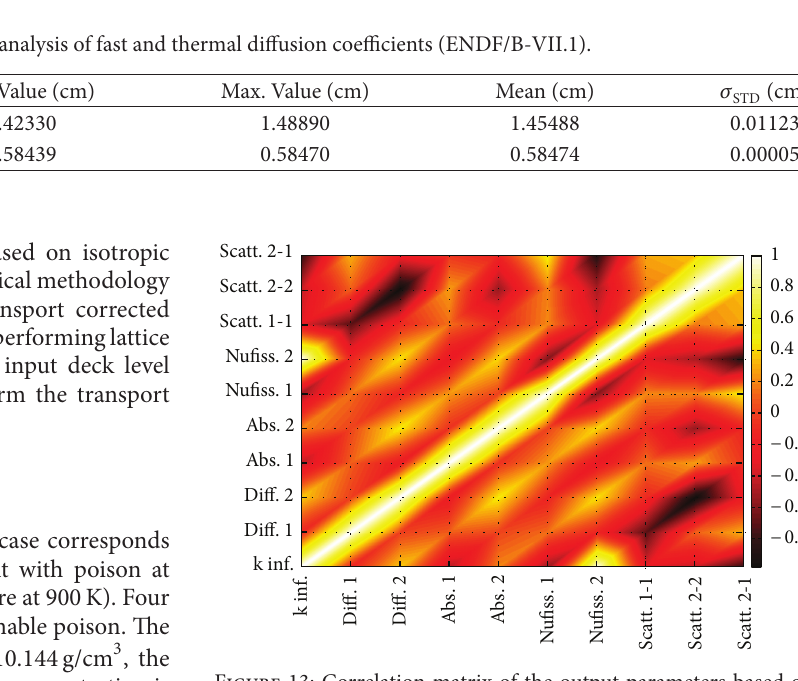
(1/cm) STD 𝜎𝜎 6.904𝑒𝑒 𝑒 0𝑒 2.904𝑒𝑒 𝑒 0𝑒 2.938𝑒𝑒 𝑒 0𝑒